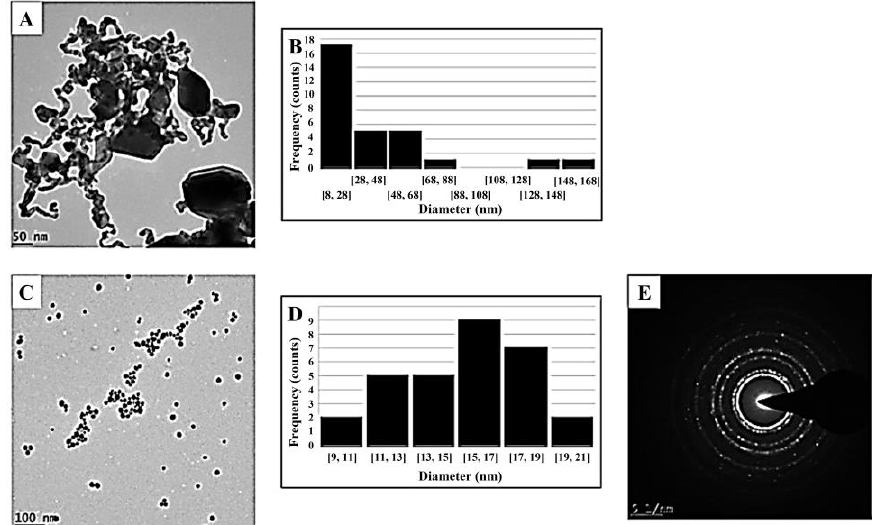
Figure 2. TEM images ( A , C ) and NP size distribution ( B , D ) for the cAuNPs prepared using a gold salt:citrate ratio of 2.5:1 ( A , B ) and the optimized ratio at 0.022:1 ( C , D ). The SAED ( E ) pattern obtained for the cAuNPs synthesized with a metal salt: citrate 0.022:1 ratio.